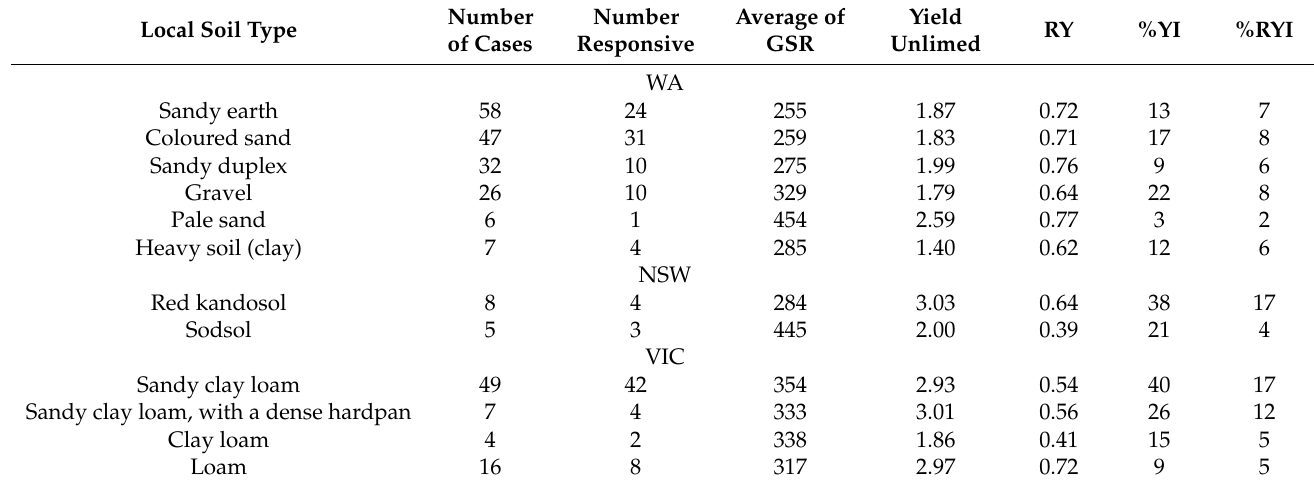
Table 4. Effect of soil type on response to lime. Each case was classified for local soil type, average growing season rainfall (GSR), yield and relative yield on the unlimed treatments, and the yield increase and increase in relative yield on the limed